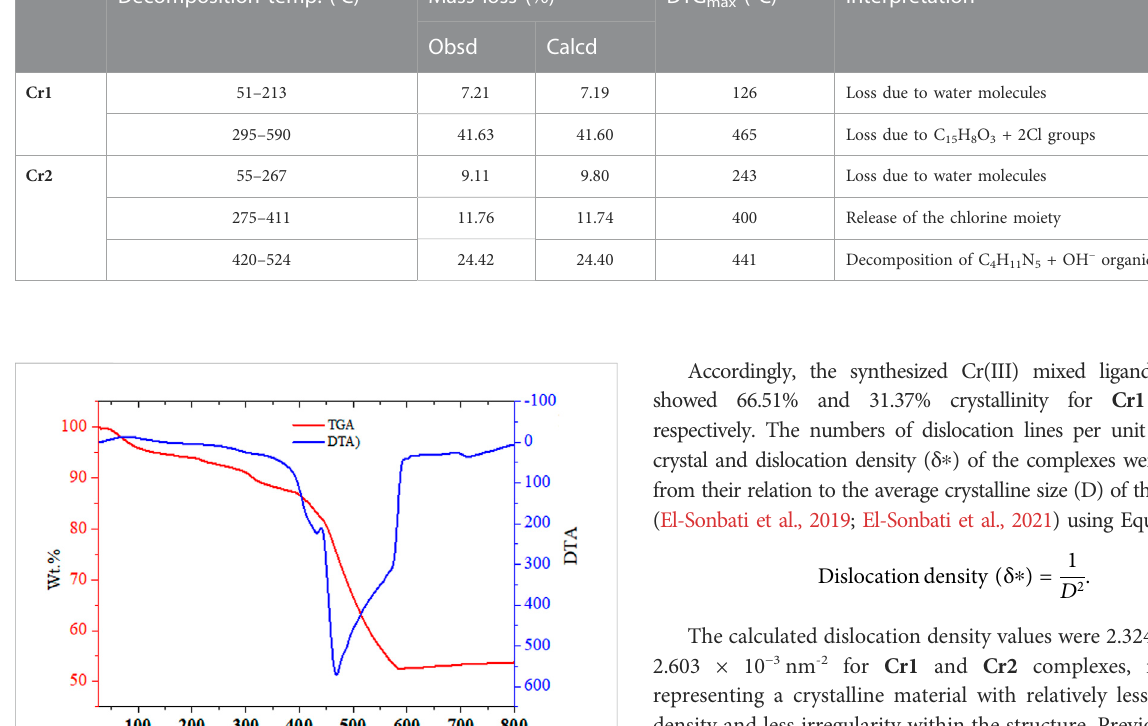
TABLE 2 Temperature range values for decomposition and corresponding weight loss values. Decomposition temp. ( ° C)